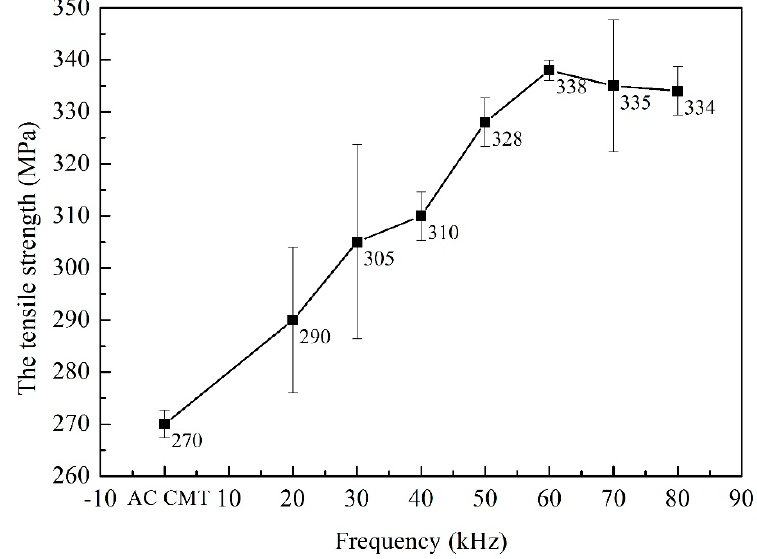
Figure 10. The tensile strength of joints welded by AC CMT and AC CMT coupled current at frequency of 20 kHz, 30 kHz, 40 kHz, 50 kHz, 60 kHz, 70 kHz and 80 kHz, respectively.